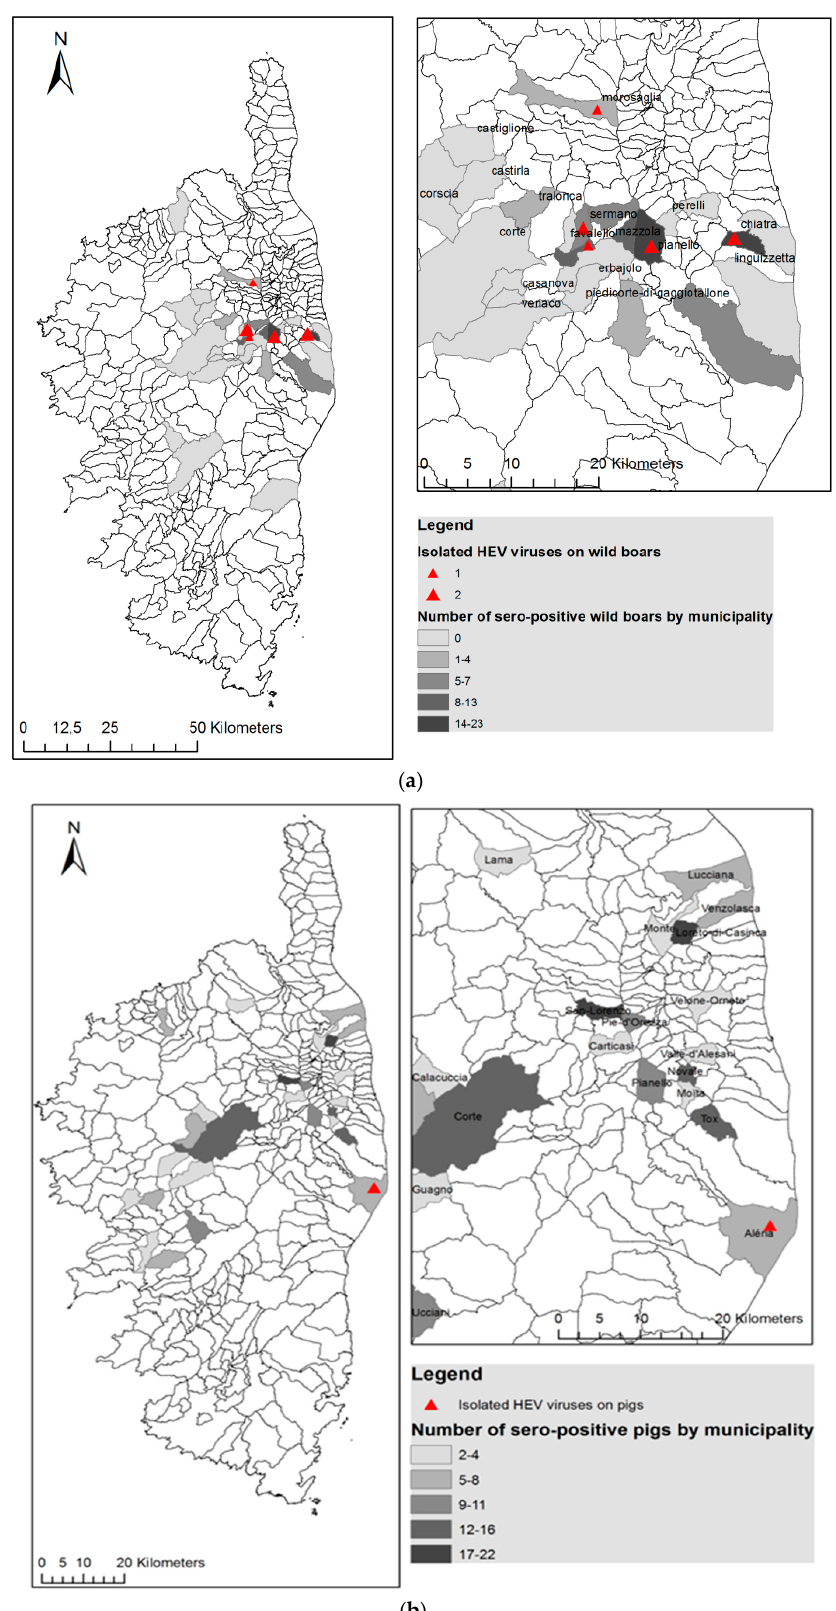
Figure 1 . Map of Corsica showing the overall distribution of seropositivity to hepatitis E virus (HEV) antibodies and the locations where HEV was isolated ( a ) in wild boar and ( b ) in domestic pigs.